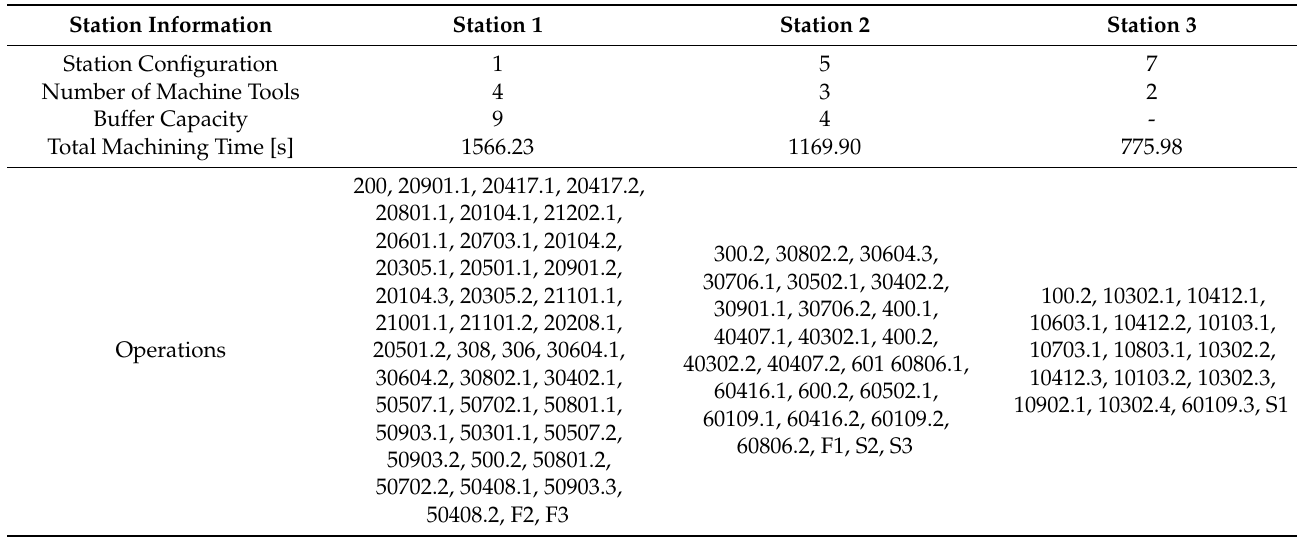
Table A12. The detailed solution of the leader solution of Cluster 5 in Table 4 (Case A). Station configuration was coded according to Table A4. The buffer capacity is the number of buffer positions at the end of the considered station, so the last station has no buffer position. Operations reports the sequence of allocated machining operations to the